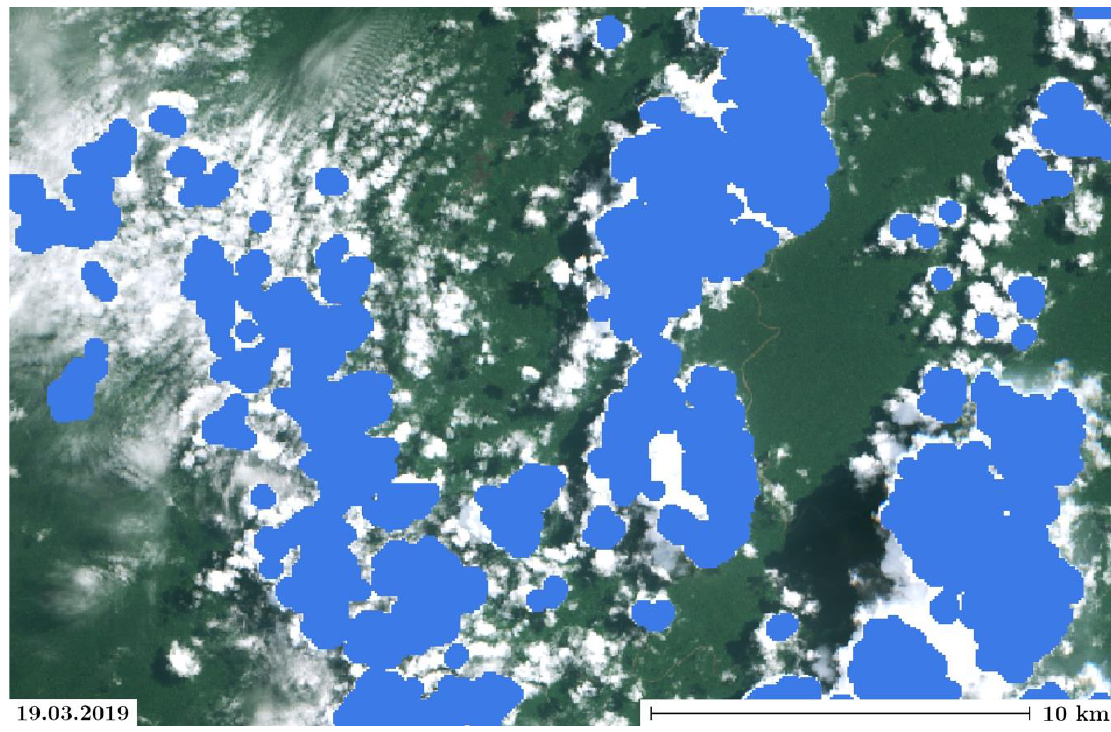
Figure 3. Cloud cover mask offered with the Sentinel-2 Level-1C and Level-2A data products.